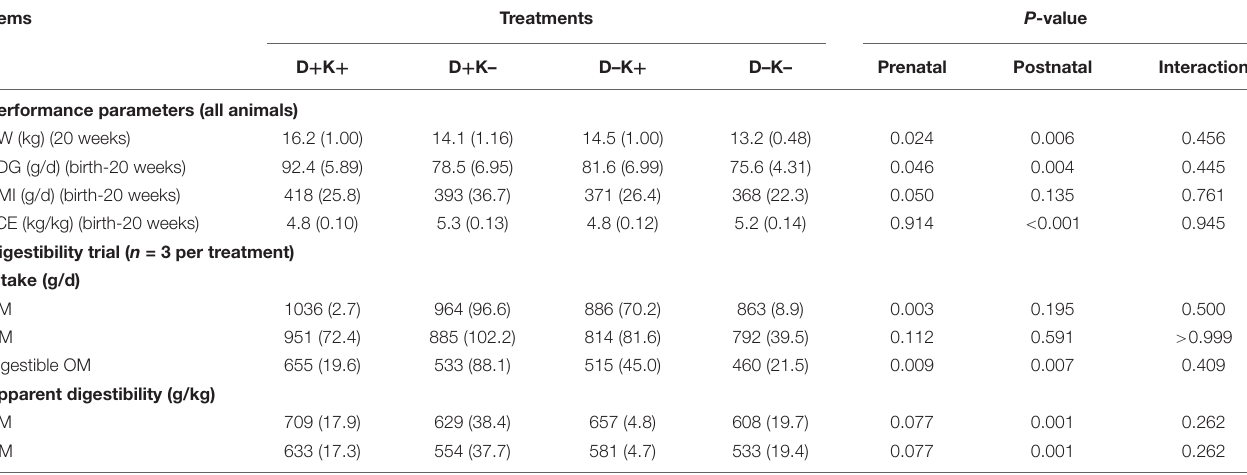
TABLE 4 | Mean (standard deviation) of body weight (BW) of goat kids at 20 weeks of age and average daily gain (ADG), dry matter intake (DMI) and feed conversion efficiency (FCE) over the first 20 weeks of life (all kids) as well as mean (standard deviation) of DM, OM and digestible OM intake and apparent digestibility of DM and OM obtained during the digestibility trial of 5 days at 20 weeks of age ( n = 3 per